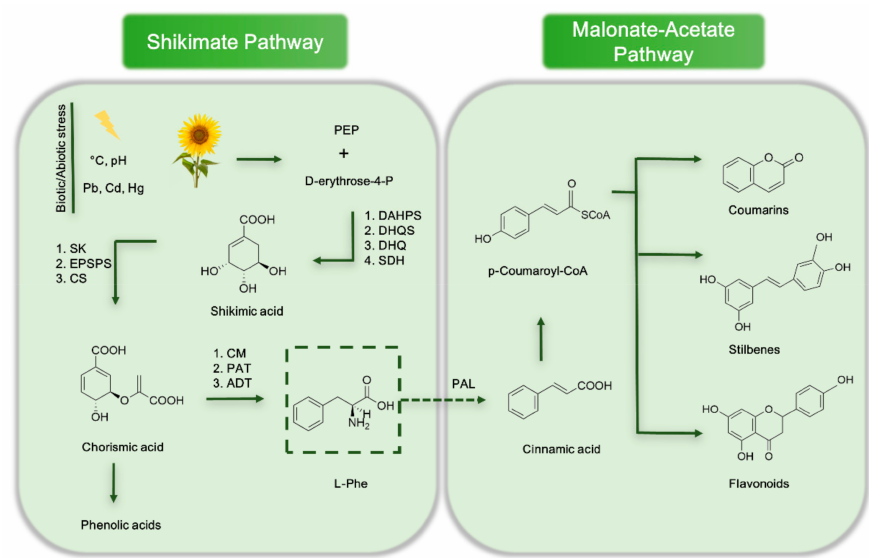
Figure 1. Schematic showing of the shikimate and malonate-acetate pathway in plants. Note: DAHPS—3-deoxy- D -arabino-heptulosonate-7-phosphate synthase; DHQS—3-dehydroquinate syn- thase; DHQ—3-dehydroquinate dehydratase; SDH—shikimate dehydrogenase; SK-shikimate kinase; EPSPS—5-enolpyruvylshikimate 3-phosphate synthase; CS—chorismate synthase;